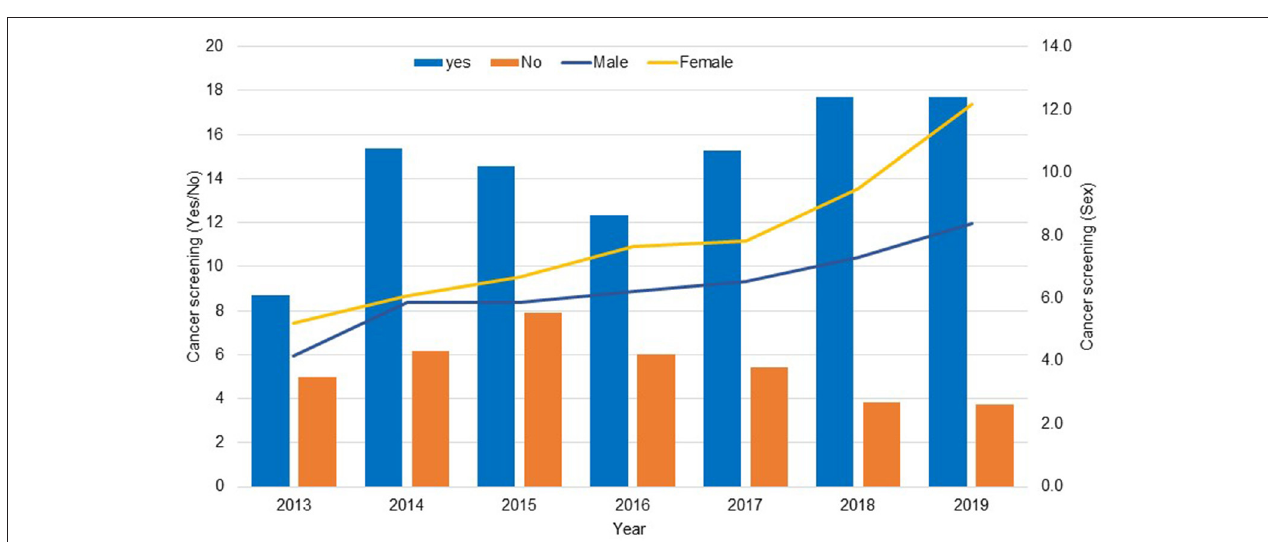
FIGURE 2 | Frequency distribution of cancer screening (Yes/No) and sex based on the KNHANES data 2013–2019.